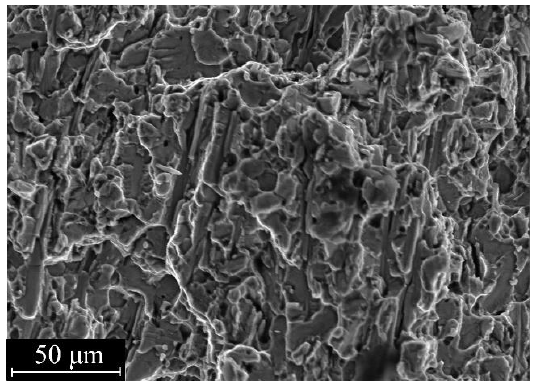
Figure 9. Fractographic investigation of Ti-TiB titanium alloy welded joint produced by electron-beam welding, ×500.